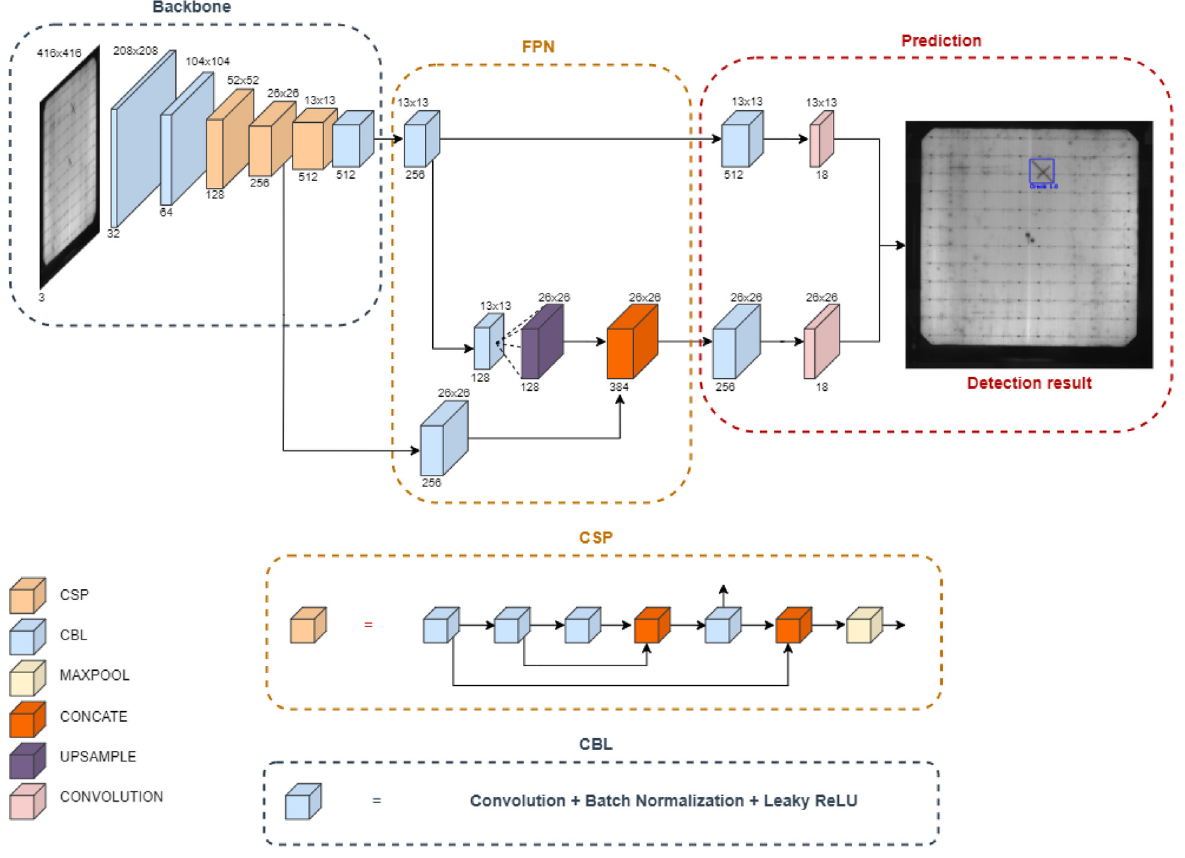
Fig. 4. The architecture of original light-weighted